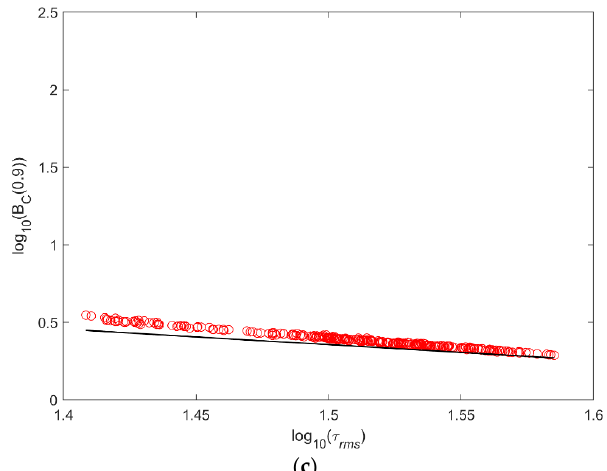
Figure 1. Relationship between pairs of values ( τ rms , B C ) for different frequency correlation levels, c f . ( a ) c f = 0.5. ( b ) c f = 0.7. ( c ) c f = 0.9. Bc : coherence bandwidth; τ rms : root mean square delay spread.